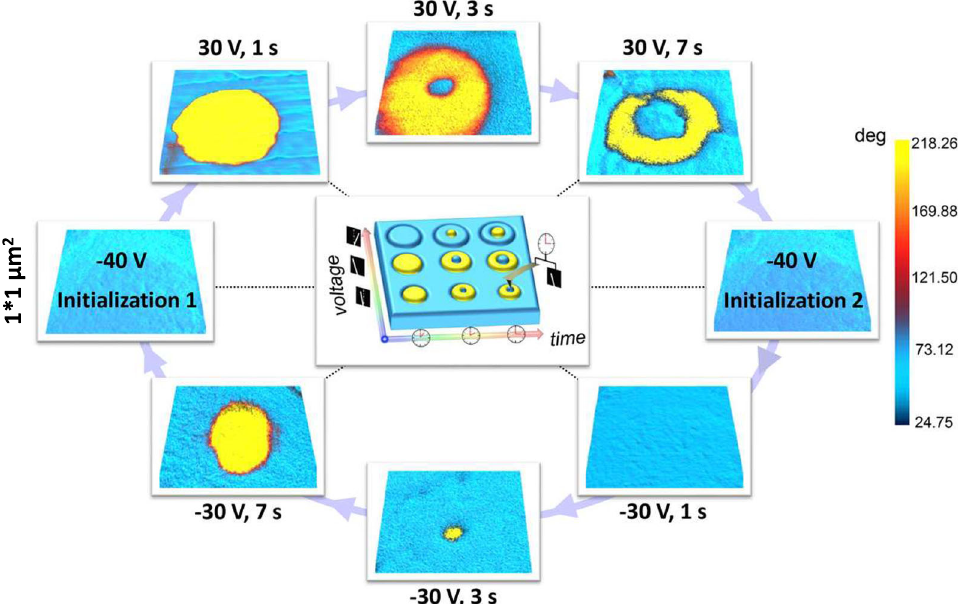
Fig. 5 Potential applications toward high-density ferroelectric memories. The voltage-induced domain evolution was performed by PFM. A preprocessing − 40-V voltage was fi rst applied to a 1*1- μ m 2 bubble region for the initialization, then a tip voltage of (±30 V, 1 − 7 s) was applied to one point to trigger donut-like topological domains with opposite polarizations. The whole process is reversible. Detailed tip-voltage-manipulated evolution of domain morphologies can be seen in Supplementary Figs. 17 − 19. Tests are carried out under dry atmosphere condition (humidity =